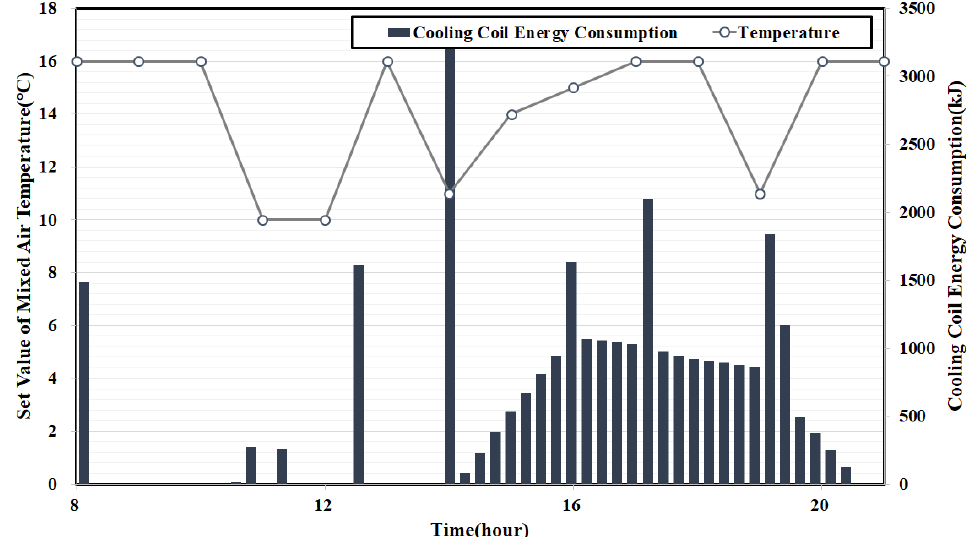
Figure 6. Hourly mixed-air temperature set point and cooling energy consumption.